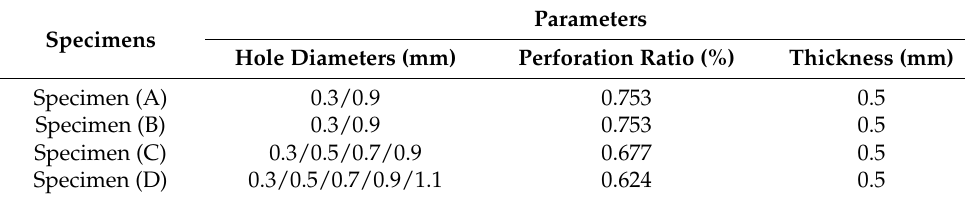
Table 1. Parameters of the specimens. Note that the perforation ratios denote average values.